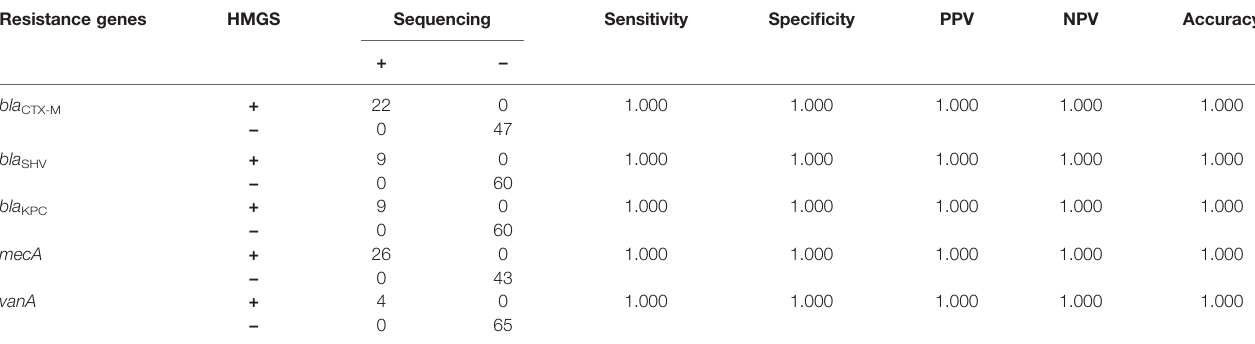
TABLE 4 | UTI-HMGS exhibited uniformly high rates of accuracy for the detection of antimicrobial resistance genes when compared to the Sanger sequencing. Resistance